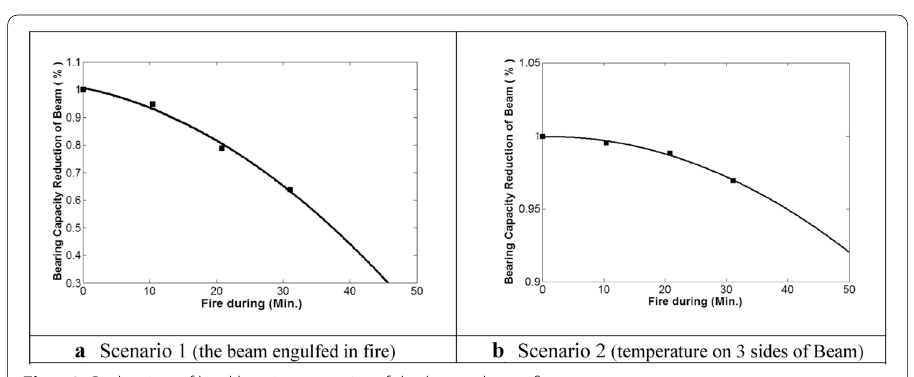
Fig. 10 Reduction of load bearing capacity of the beam due to